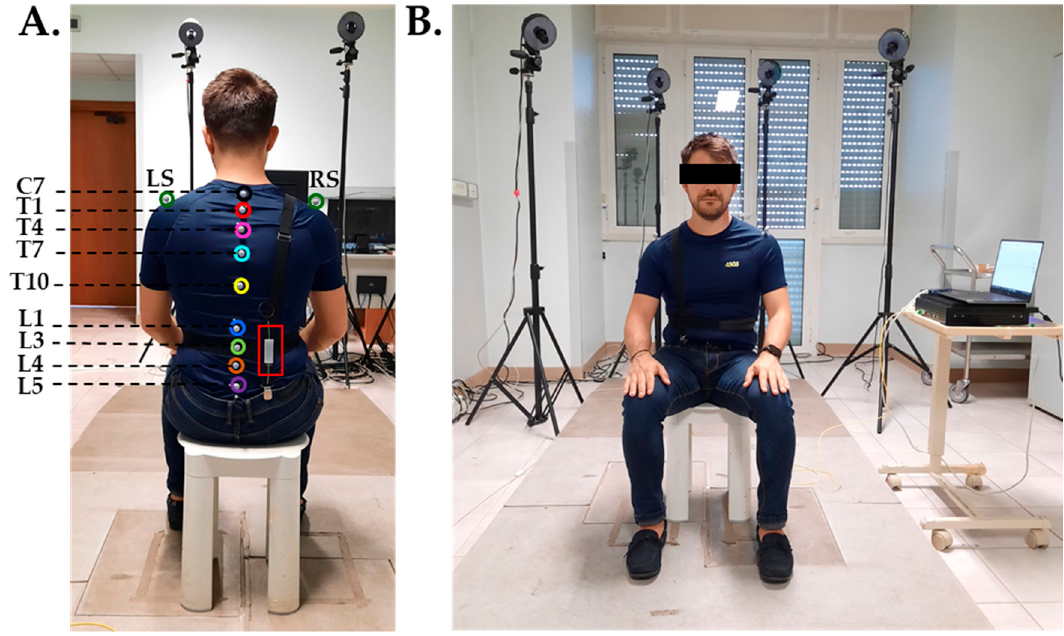
Figure 5. Experimental set up. ( A ). Back view showing the posterior part of the wearable device and the positioning of the flexible sensor (red rectangle) and the photo-reflective markers; ( B ). Frontal view showing the anterior part of the wearable device, the MoCap cameras, the optical interrogator and the laptop.